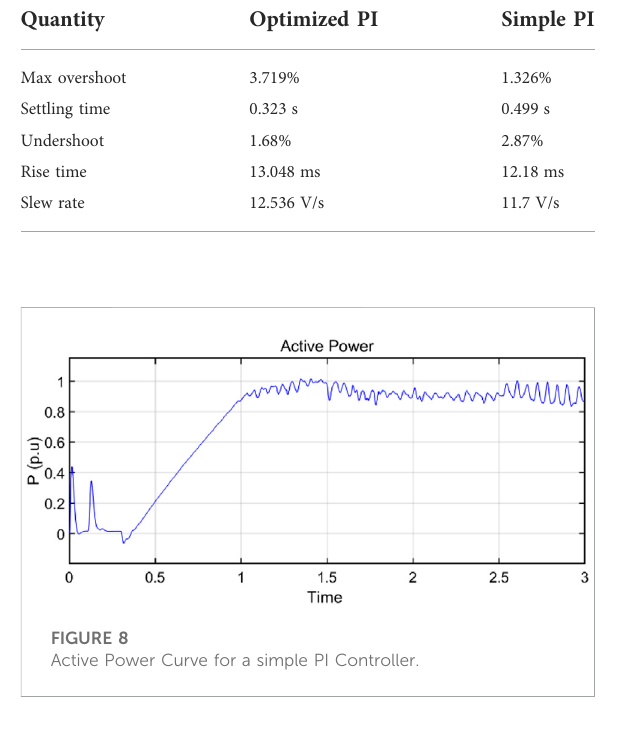
TABLE 5 Comparison of reactive power.